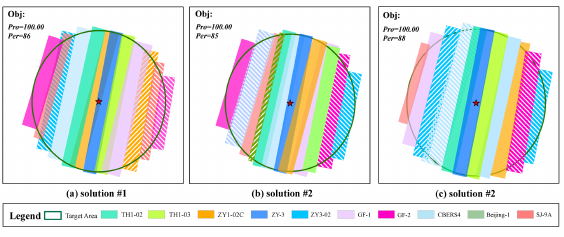
Figure 4. The scheduling schemes for Scenario A